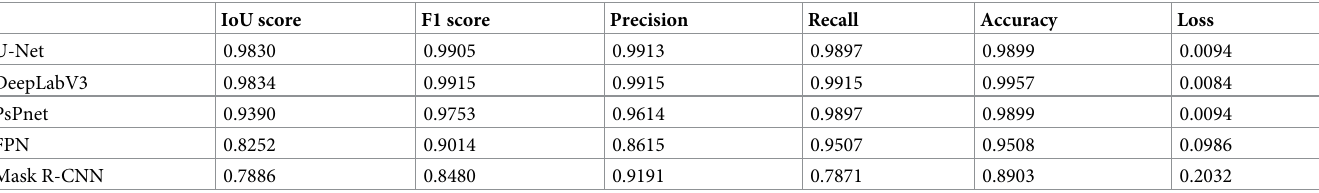
Table 4. Performance of the five models on tissue classification inside ulcerations. IoU